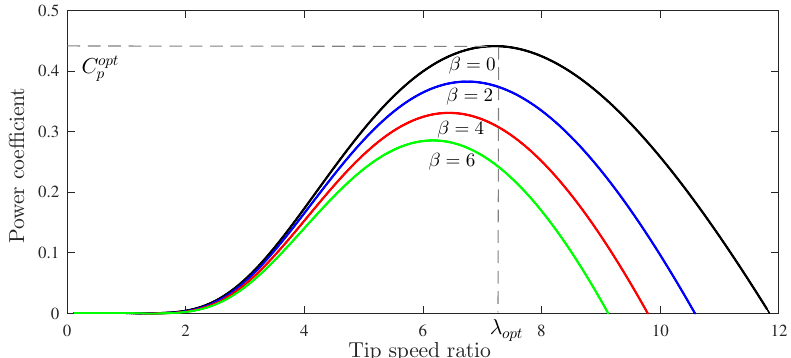
Figure 6. Power coefficient as a function of tip speed